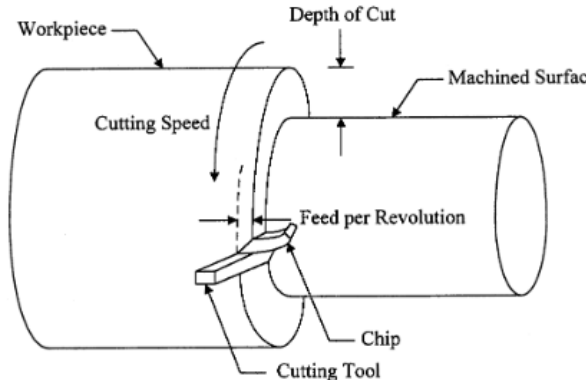
Figure 9. Operational parameters in diamond turning [68]. Reprinted with permission from [68]; 1998 Elsevier.